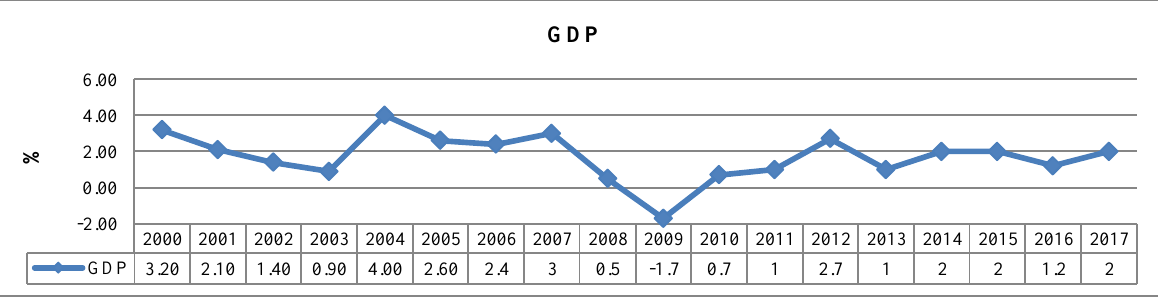
Figure 2: Norway’s GDP rate 2000-2017, (%); Source: https://databank.worldbank.org (Accessed: